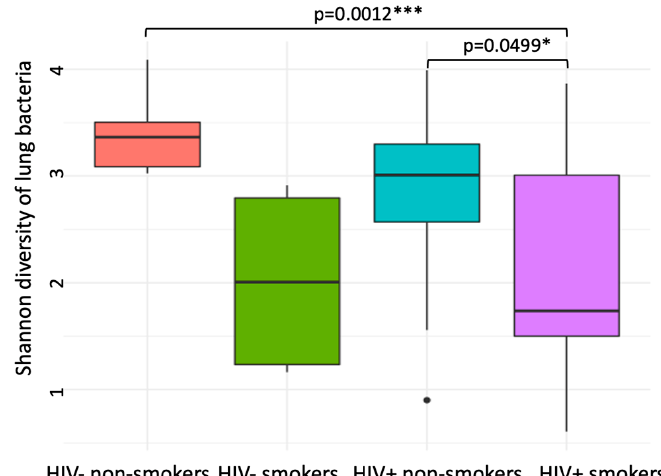
Figure 1. Lung bacterial community alpha diversity (Shannon index of relative abundance of amplicon sequence variants [ASVs] per sample) across HIV and smoking status. A two-way ANOVA was performed to test the impact of smoking and HIV status on bacteria diversity, showing significant effect of smoking ( p = 0.005) but no effect of HIV status and its interaction with smoking ( p = 0.32 and p = 0.4, respectively). Pairwise t -tests were performed to test for differences among the four groups and the significant differences are shown (* p < 0.05; *** p < 0.001).